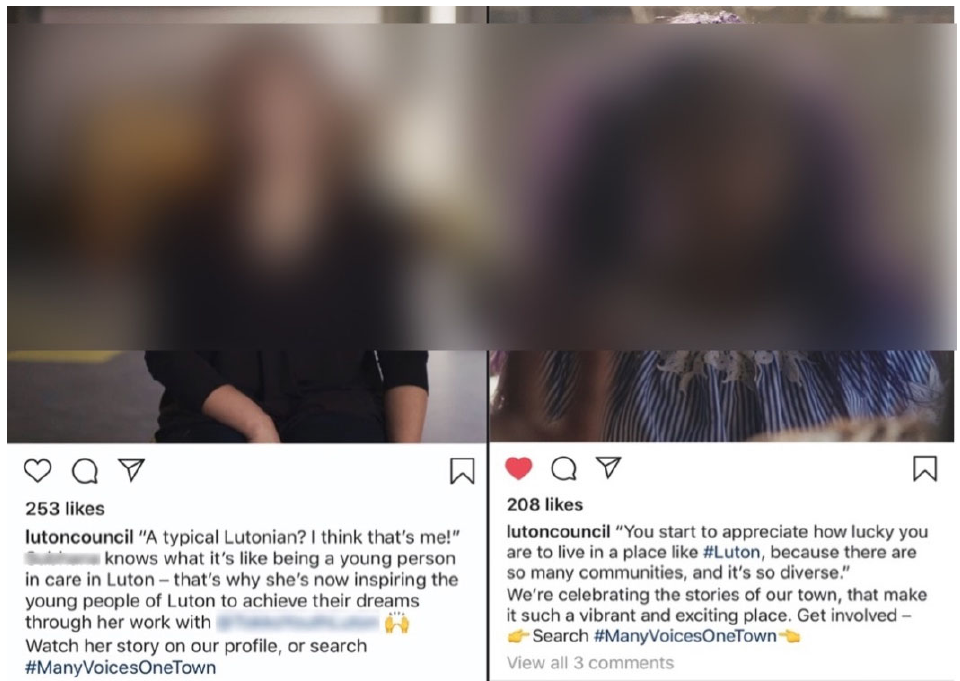
Figure 1. Many Voices One Town—Lutonians as advocates (netnographic data from Luton Council Instagram account).